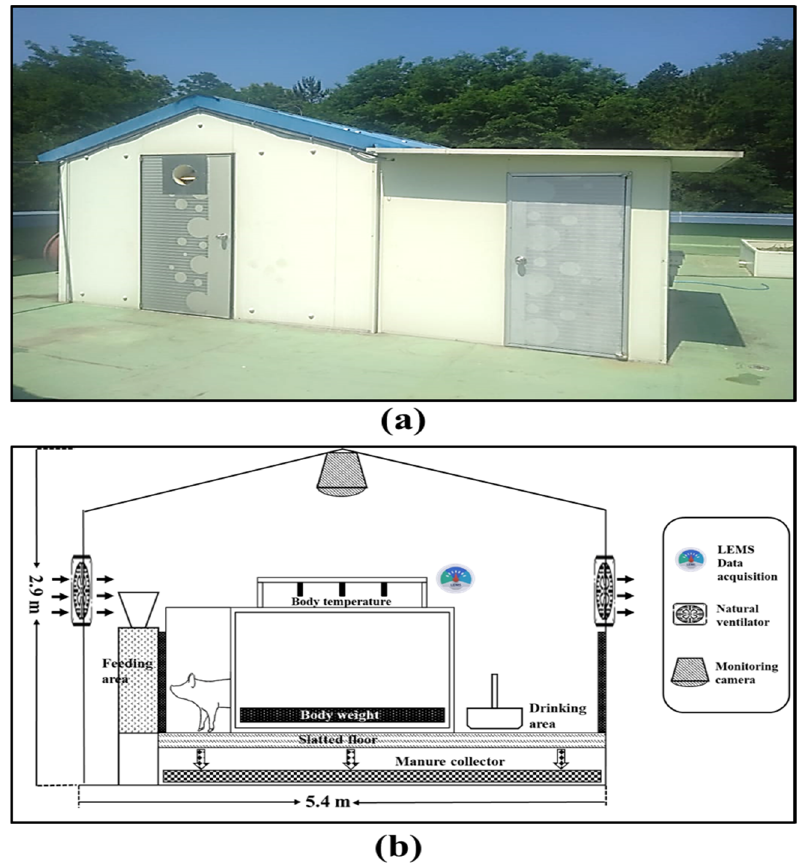
Figure 1. ( a ) Outdoor view of the model swine building which was used for current experiment; ( b ) sensor placement and indoor schematic of model swine building.